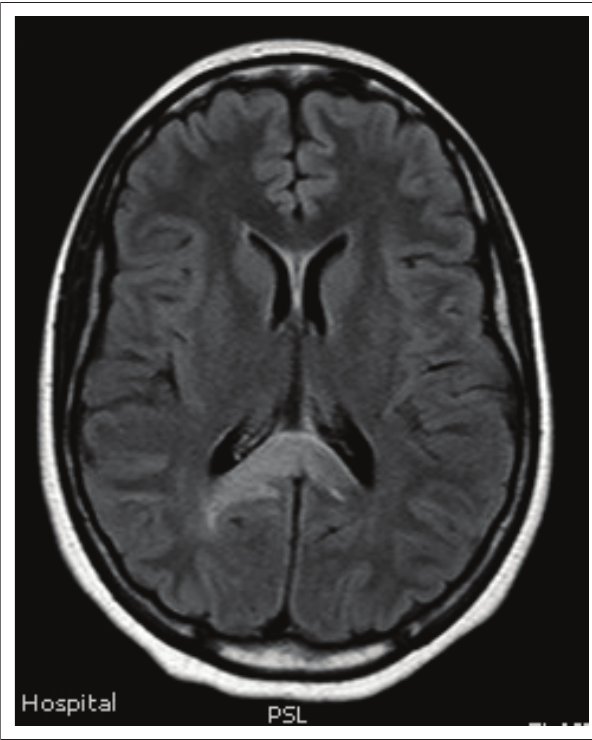
FIGURE 4: Axial fluid-attenuated inversion recovery magnetic resonance image demonstrating hyperintensity in the splenium of corpus callosum in a ‘bridging arch pattern’.